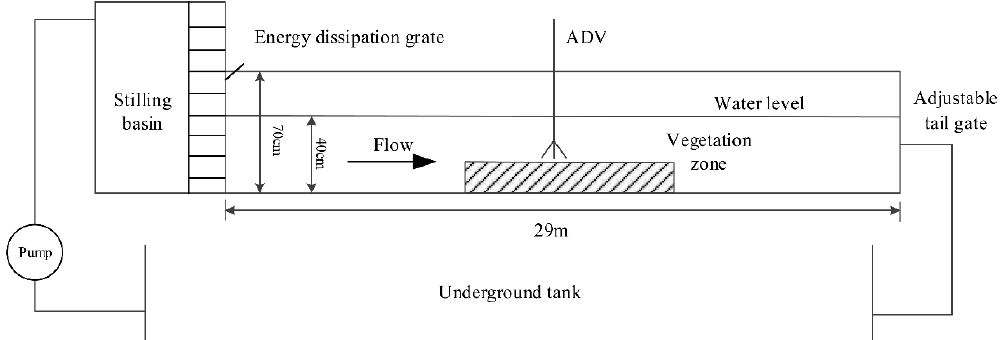
Figure 1. General layout of the open channel flume. ADV—acoustic Doppler velocimeter.